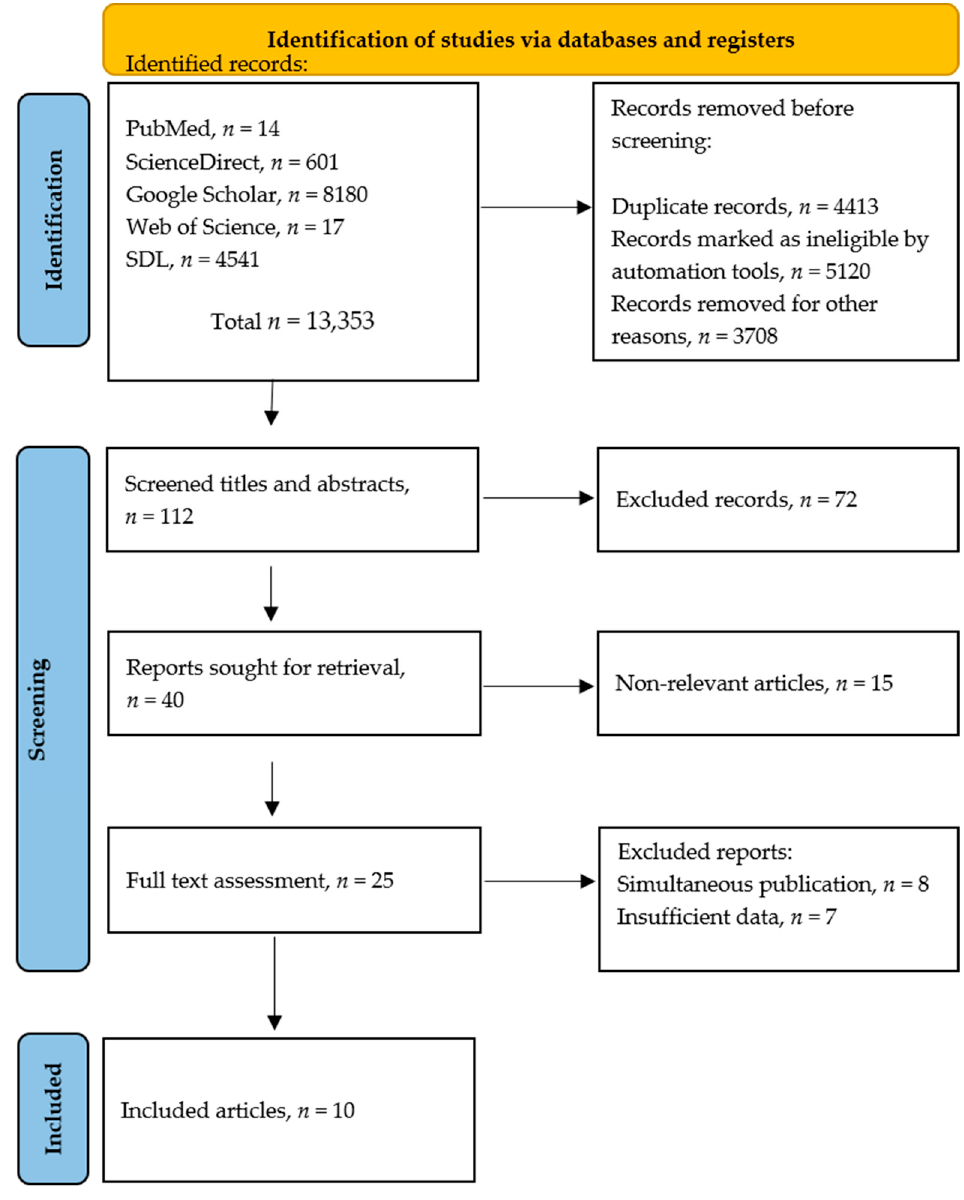
Figure 1. Schematic plan of the article selection process.